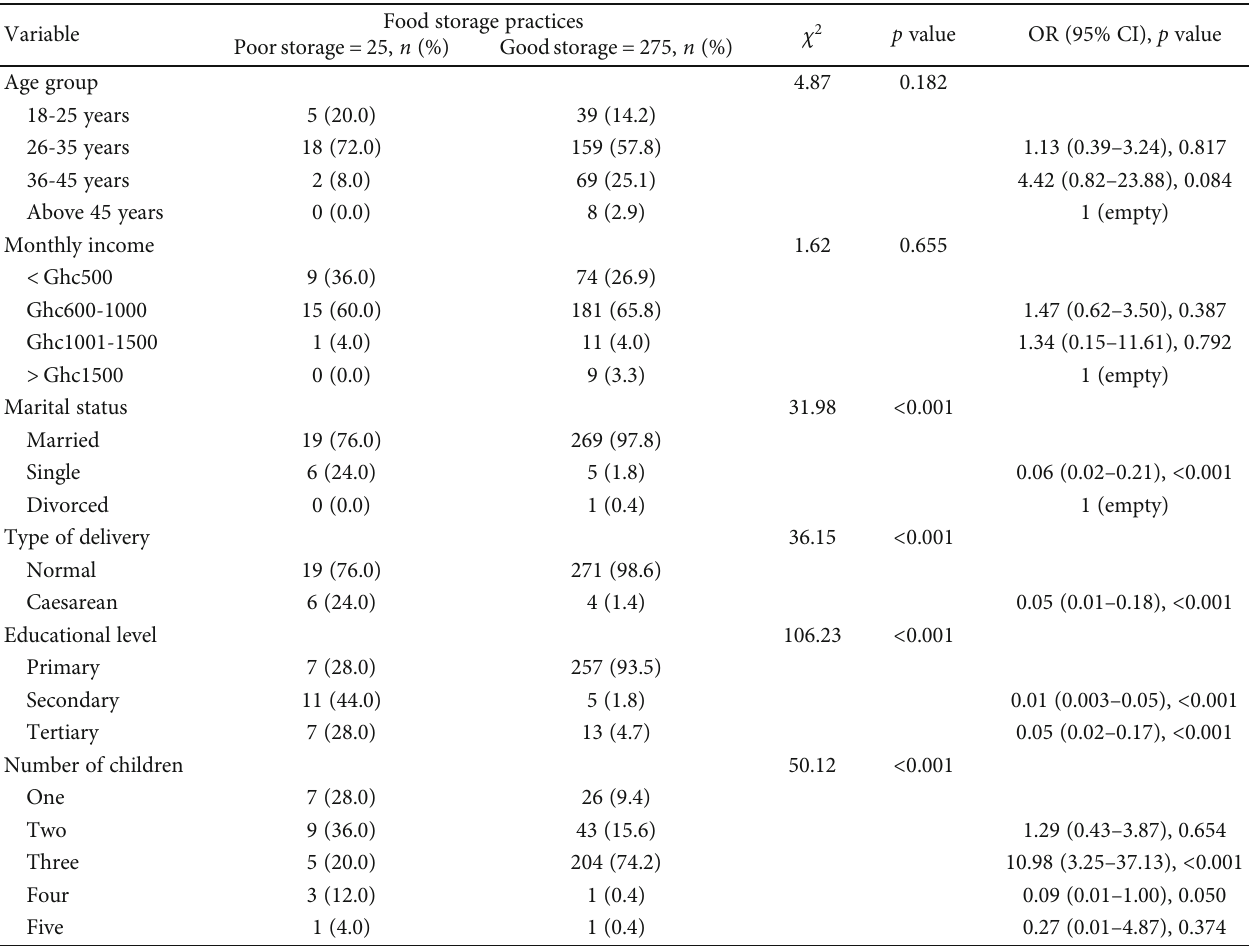
Table 7: Association between food storage practices and respondent ’ s demographic